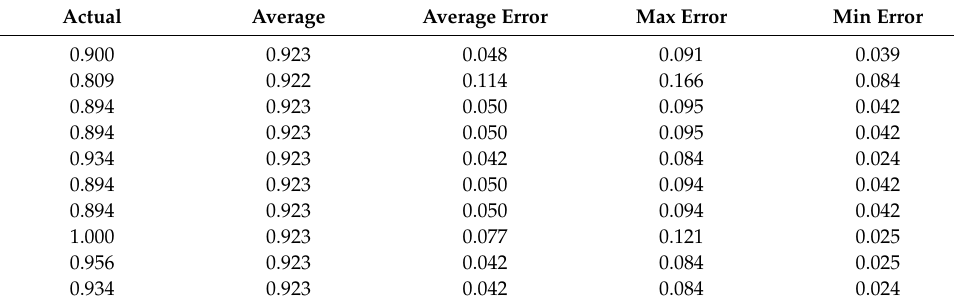
Table A96. Set 2, trials 11–20 data (actual PR